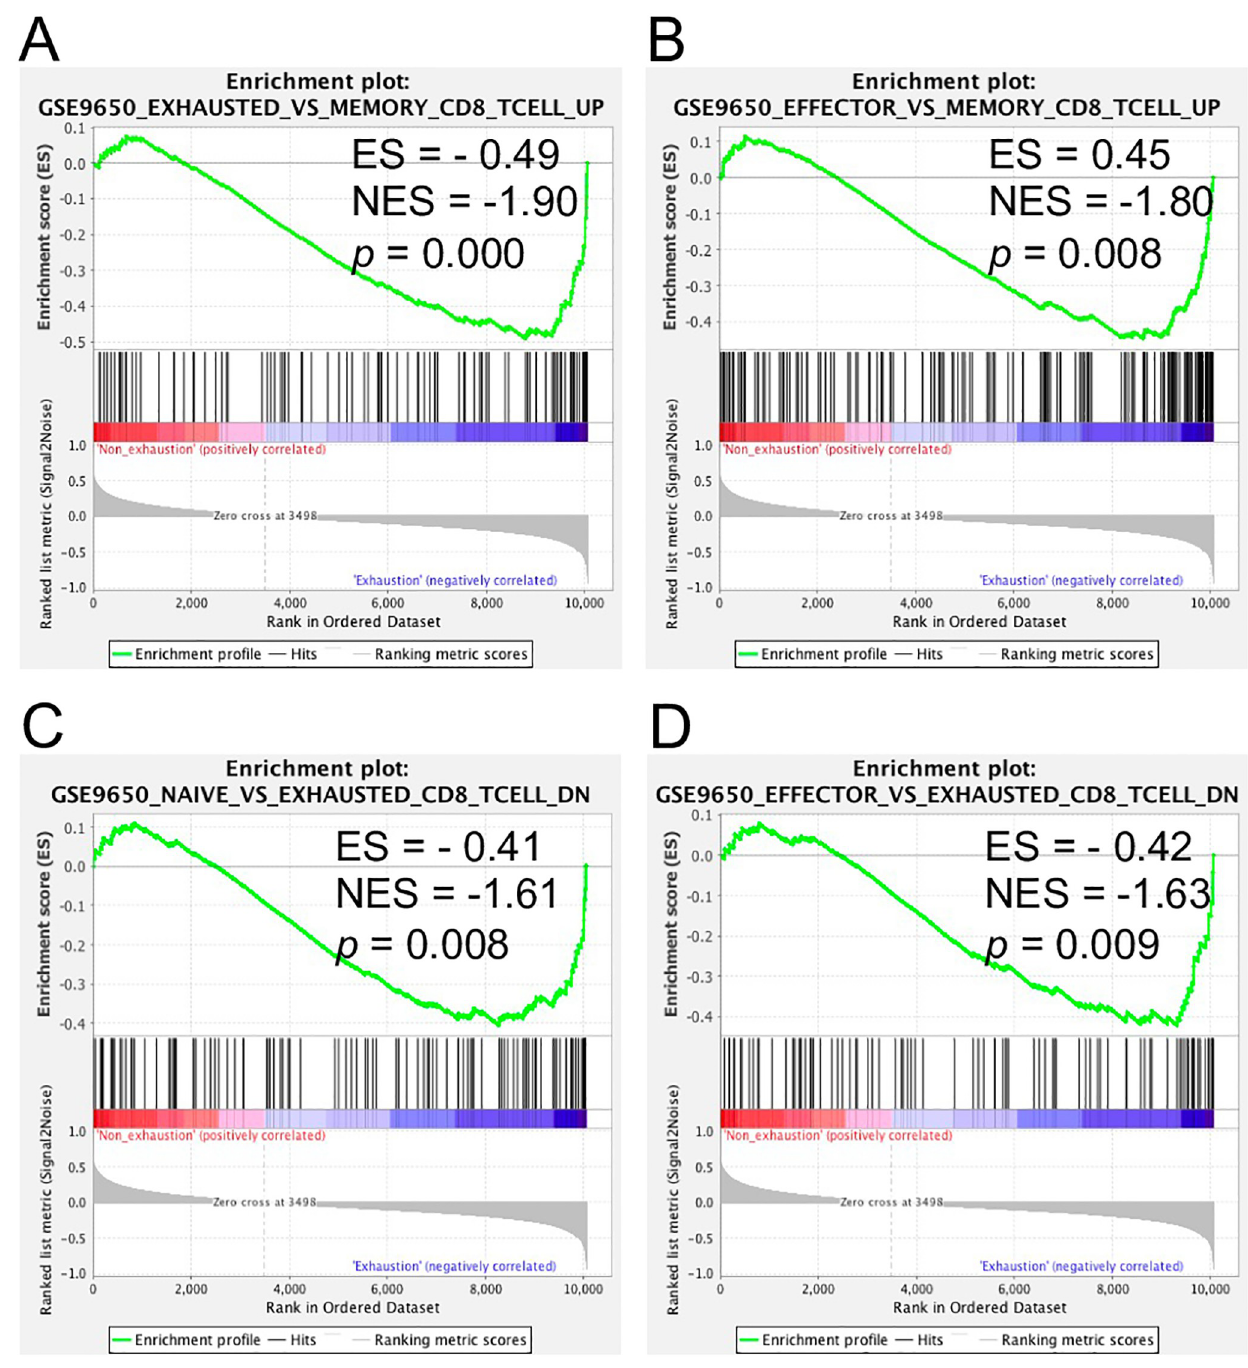
Fig 6. GSEA of exhausted versus non-exhausted CD8+ T-cells. (A–D) The four shared enriched gene sets in human exhausted T-cells with a P - value < 0.05. ES, enrichment score; NES, normalized enrichment score.